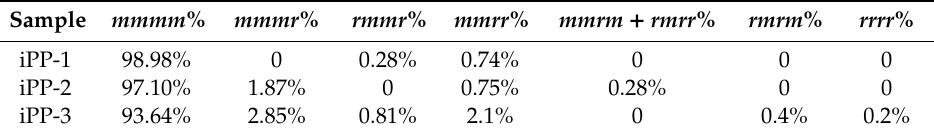
Table 1. 13 C NMR analysis of the iPP